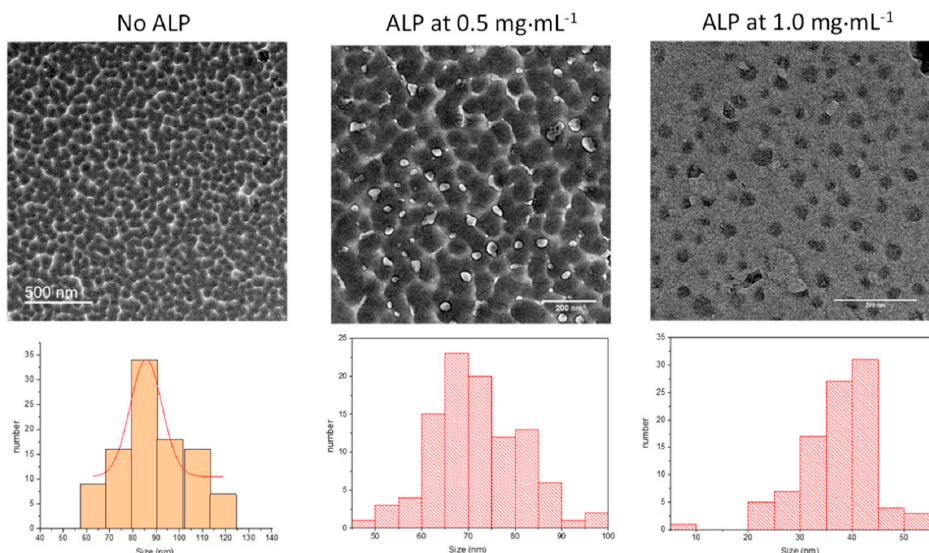
Figure 2. ( Top ) Representative TEM micrographs of polydopamine nanoparticles produced after 6 h of oxidation in the presence of 20 mM NaIO 4 from the dopamine solutions (10.6 mM) after the subsequent dialysis against Tris buffer, as a function of the added concentration in ALP. ( Bottom ) Size distribution of the particles obtained by analyzing 100 particles.